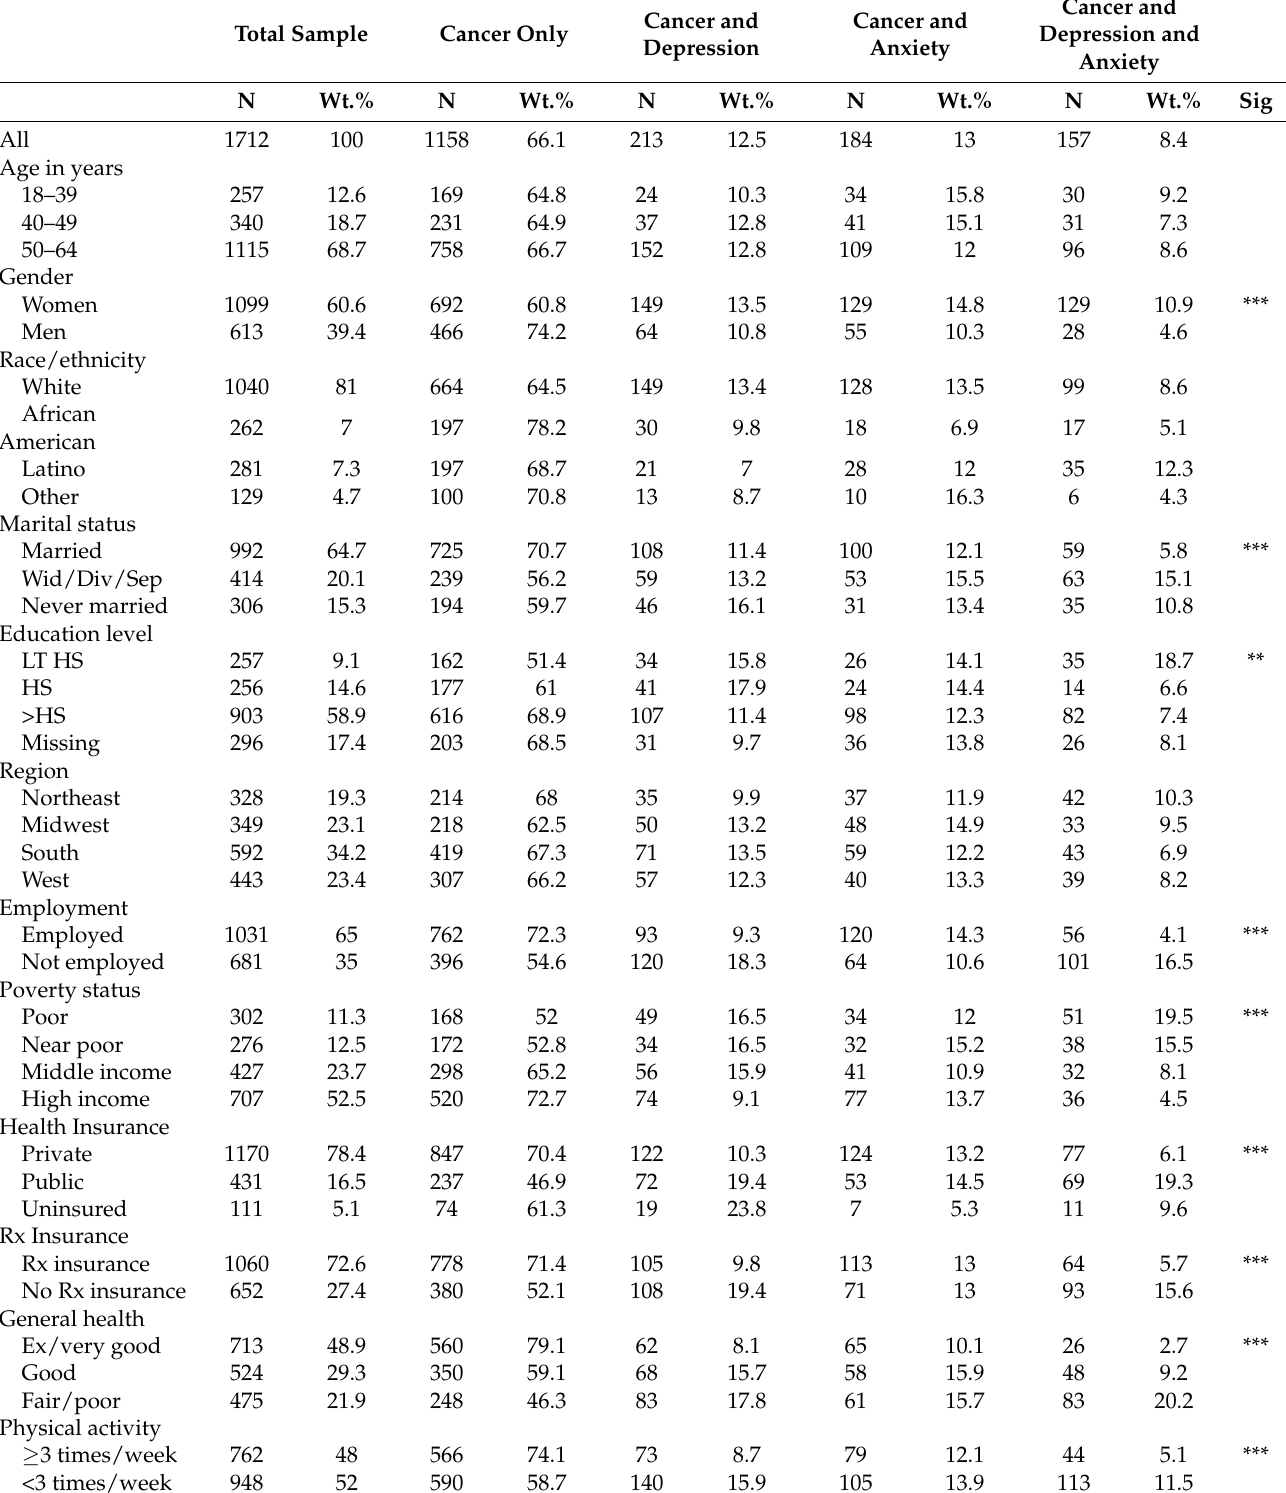
Table 1. Characteristics of the study sample (number and weighted percentage). Number and row weighted percentage of characteristics by cancer category among adults with